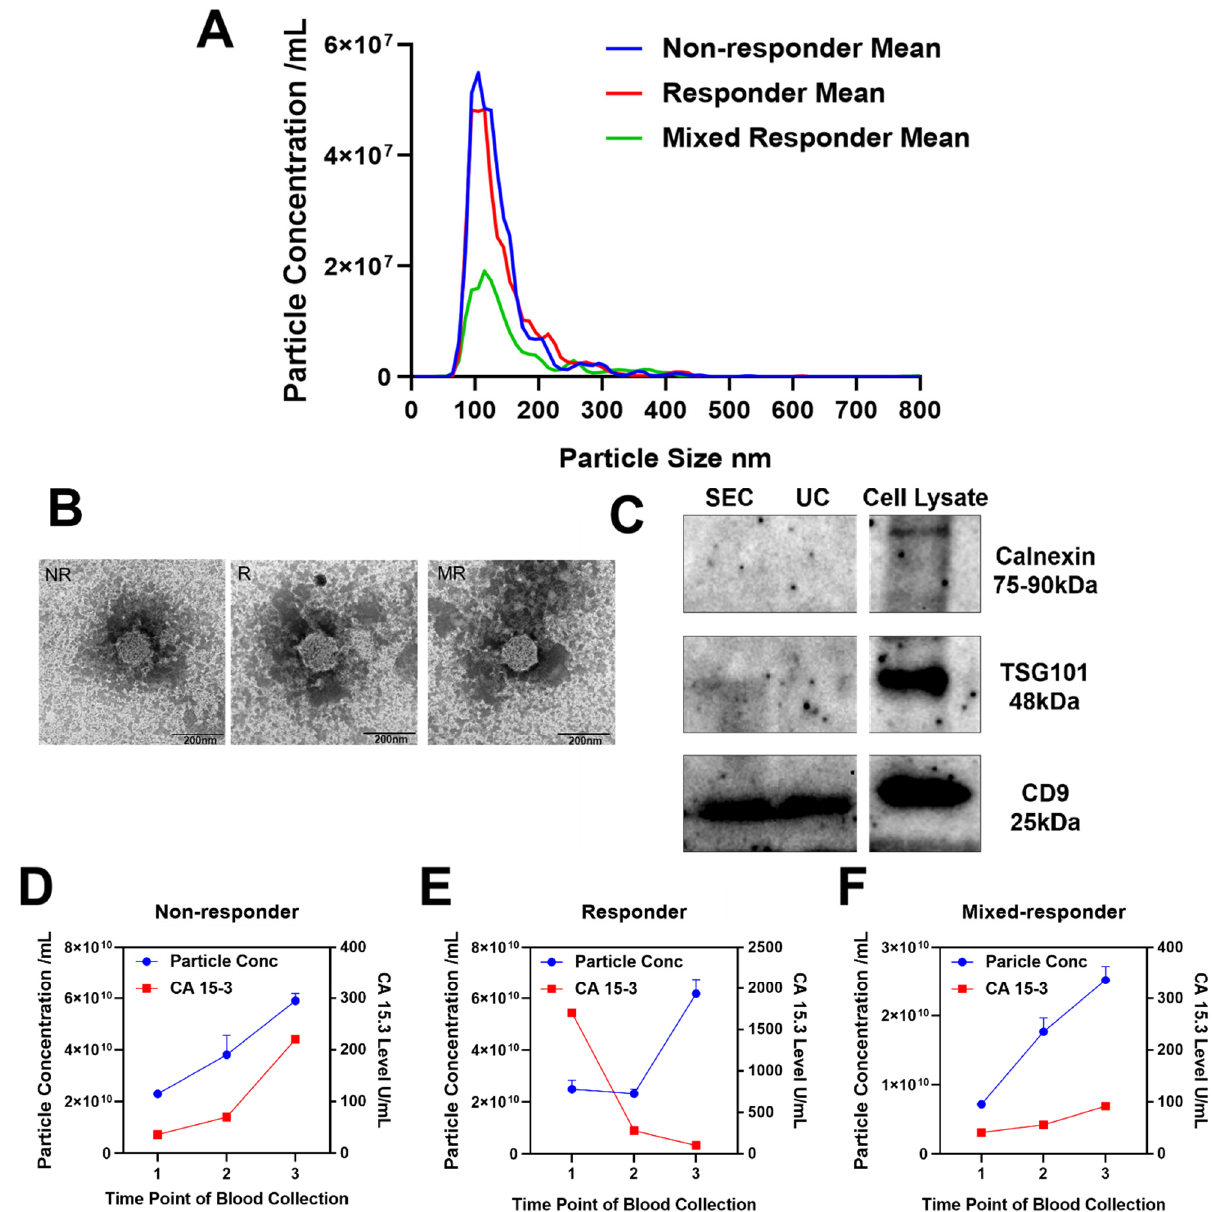
Figure 2. Validation of extracellular vesical isolation using nanoparticle tracking analysis, transmission electron microscopy and Western blotting. ( A ) Nanoparticle tracking analysis (NTA) was used to measure the mean size distribution and undiluted particle concentration of EVs from three patients. ( B ) Transmission electron microscopy images of EVs. Representative images are shown for the non-responder (NR), responder (R), and mixed-responder (MR). Scale bar, 200 nm. ( C ) Representative images of Western blotting analysis from plasma EVs (SEC pooled fractions and ultracentrifugation (UC)) and whole cell lysate of breast cancer cell line MDA-MB-231. ( D – F ) Line graphs were plotted to compare particle concentration and level of cancer biomarker CA 15.3.